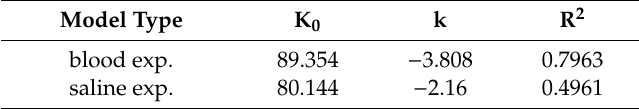
Table 5. Parameters of exponential models—y = K 0 e kx —obtained from the 0–6%